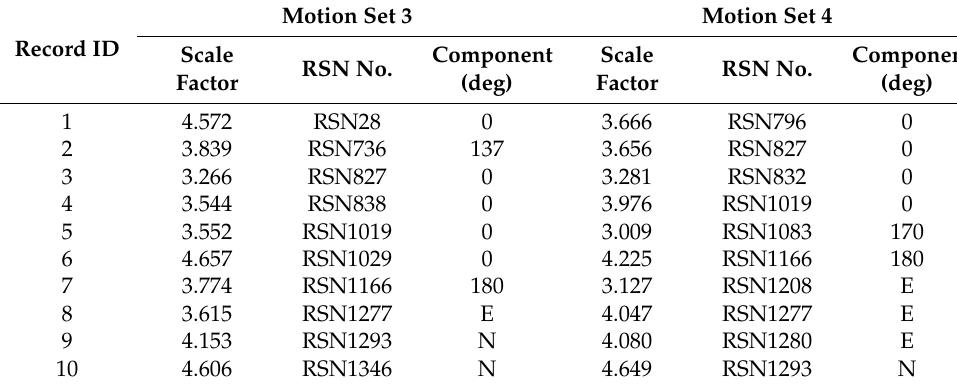
Figure A3. Mean spectra of IGMs selected from motion sets 1 and 2 with different selection procedures. Table A2. Details of IGMs of motion sets 3 and